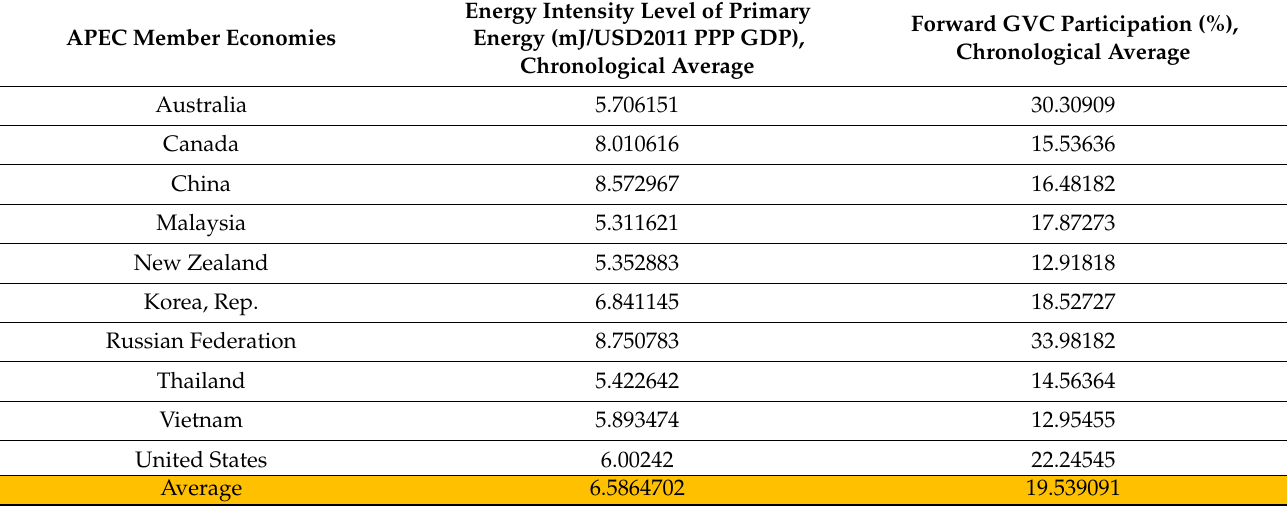
Table 14. APEC member economies with higher energy intensity level of primary energy.